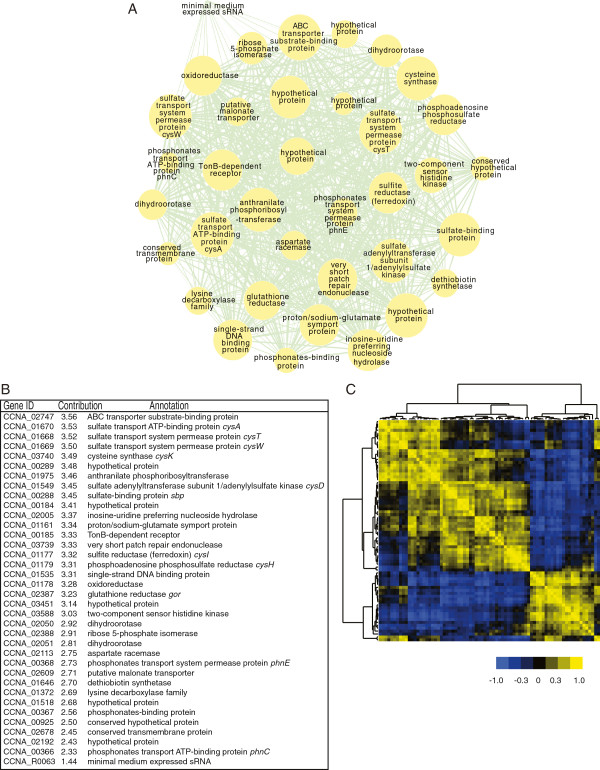
WGCNA co-expression modules. (A) WGCNA modules were constructed based on the Topological Overlap Matrix. This is an example displaying the topology of the magenta module. Nodes are genes, and the size of node is proportional to its contribution in forming this module. Width of the edges is proportional to strength of correlation between two connected genes. (B) Table showing the contribution of all member genes to the formation of the magenta module. (C) Clustering of the 76 modules shows as a 76 by 76 heat map matrix resulted from bi-clustering based on the module eigenvectors. The eigenvector of the expression matrix for each module was used to represent its expression profile. Each row or column is one module, and the color in each small cell describes the relationship between two modules. Yellow shades indicate positive correlations (i.e., similar expression profiles) between two modules, whereas blue shades mean anti-correlations. Black indicates no correlation.